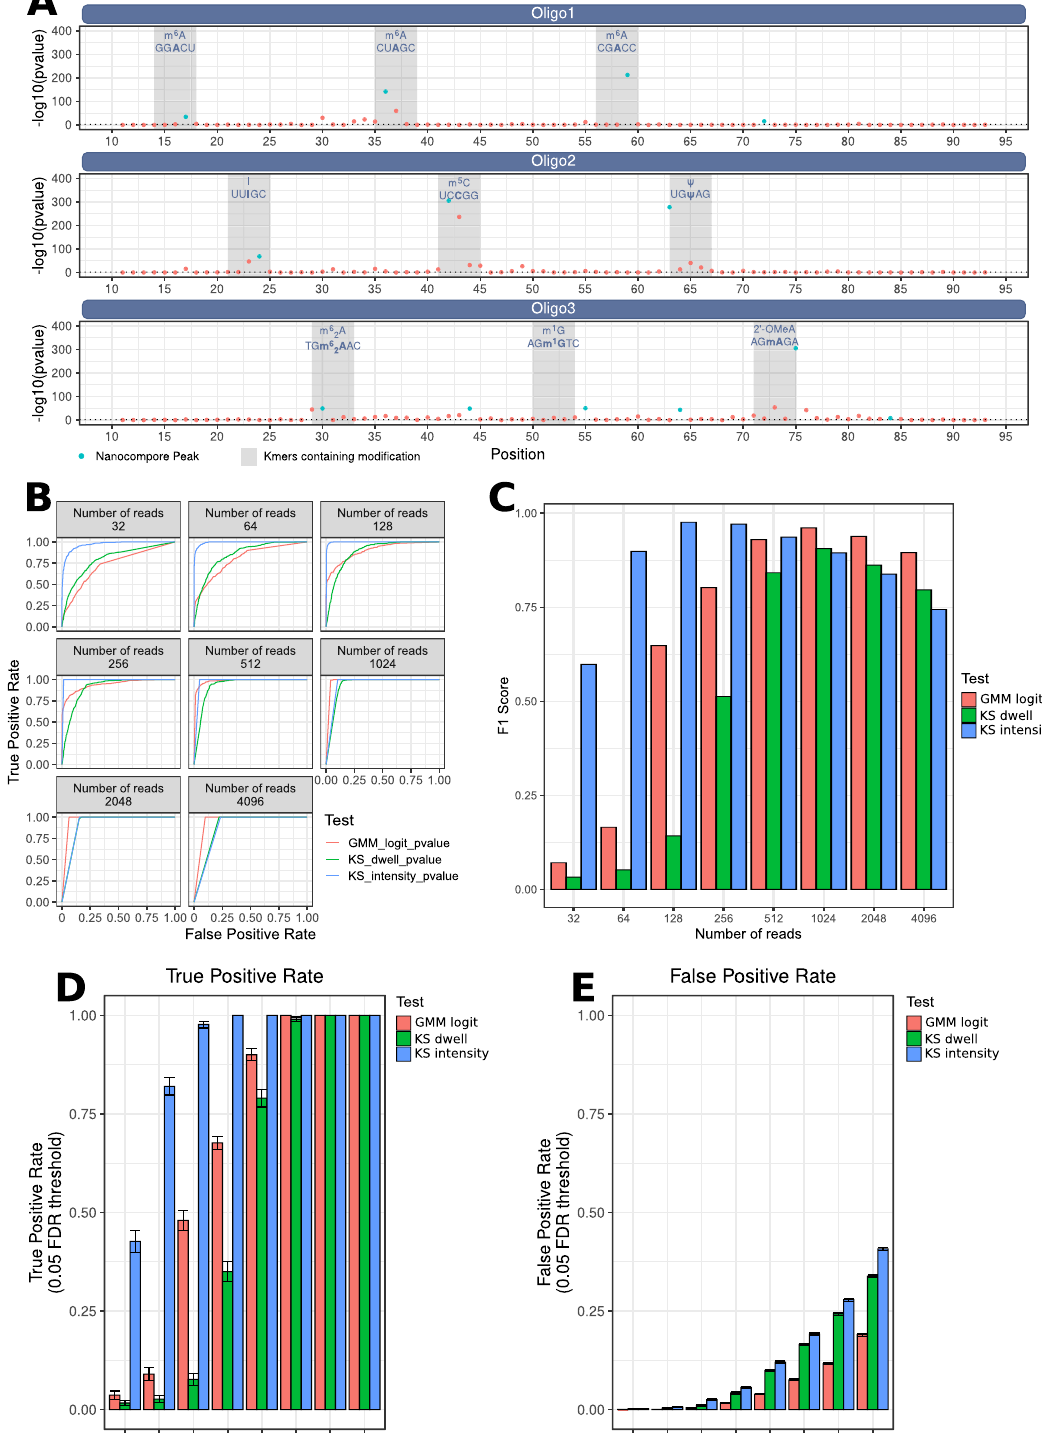
generated 100 independent datasets that were then analysed with Nanocompore, for a total of 80,000 runs (Fig. 3A). By knowing the ground-truth modi fi cation state in each run we could measure accuracy and produce ROC curves for all conditions tested (Fig S4, S5, S6). As expected, we observed that the accuracy varied greatly according to the coverage as well as to the relative fraction of modi fi ed reads in the test and control conditions (Fig S7).